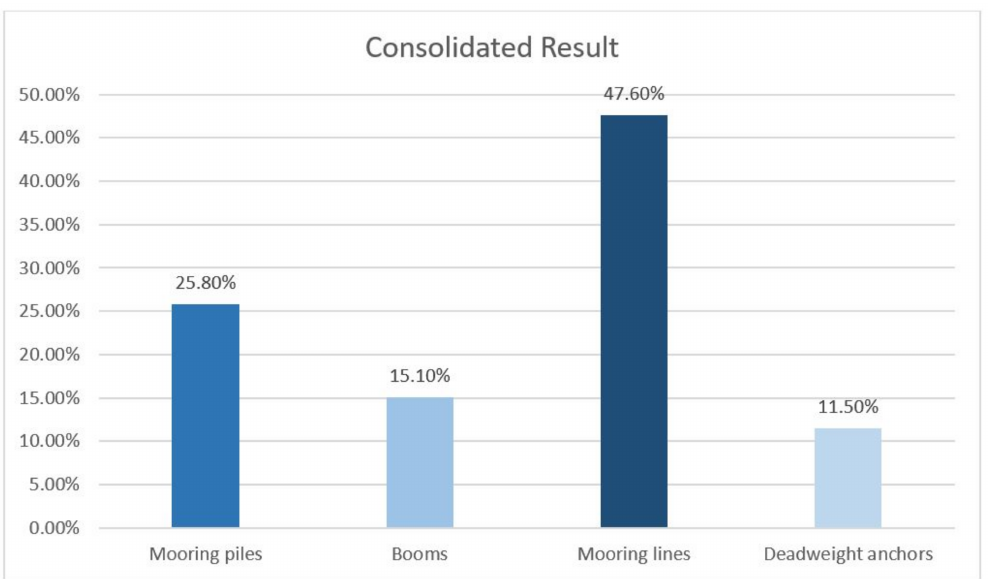
Figure 3. A pie chart of the global priorities [authors’ own work].